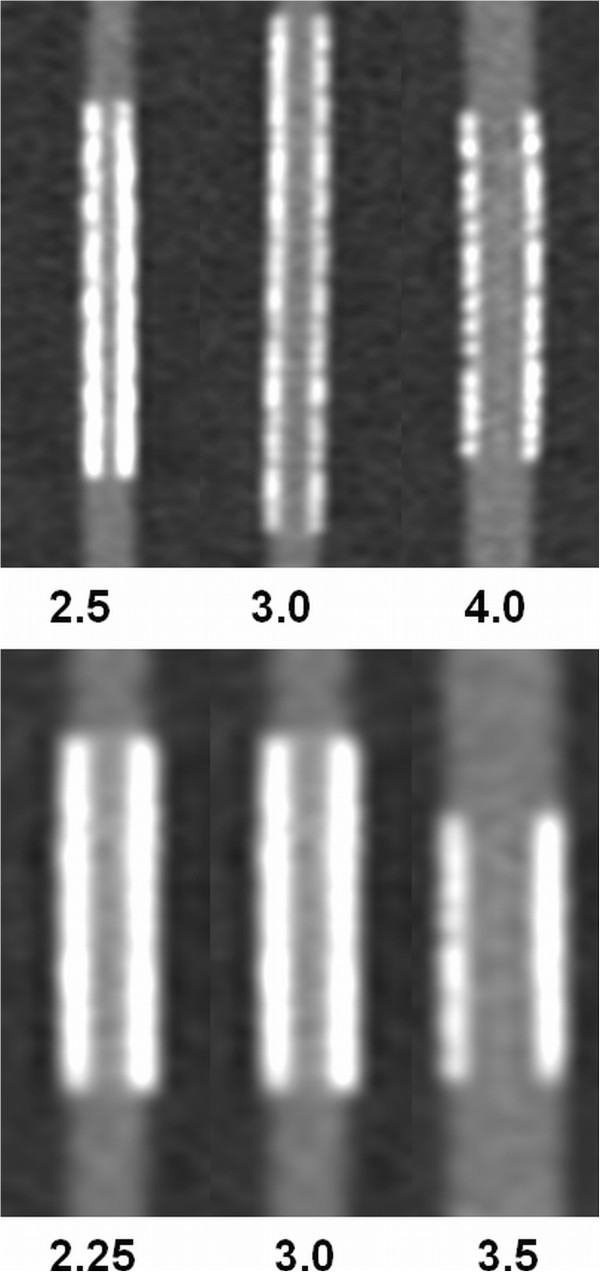
Effect of different stent diameter. Reconstructions of three different sizes of the same stent type (top: Biotronik PRO-Kinetic, bottom: Medtronic Endeavor Resolute). Diameter is given in mm. Zoom factors differ between the stent types.